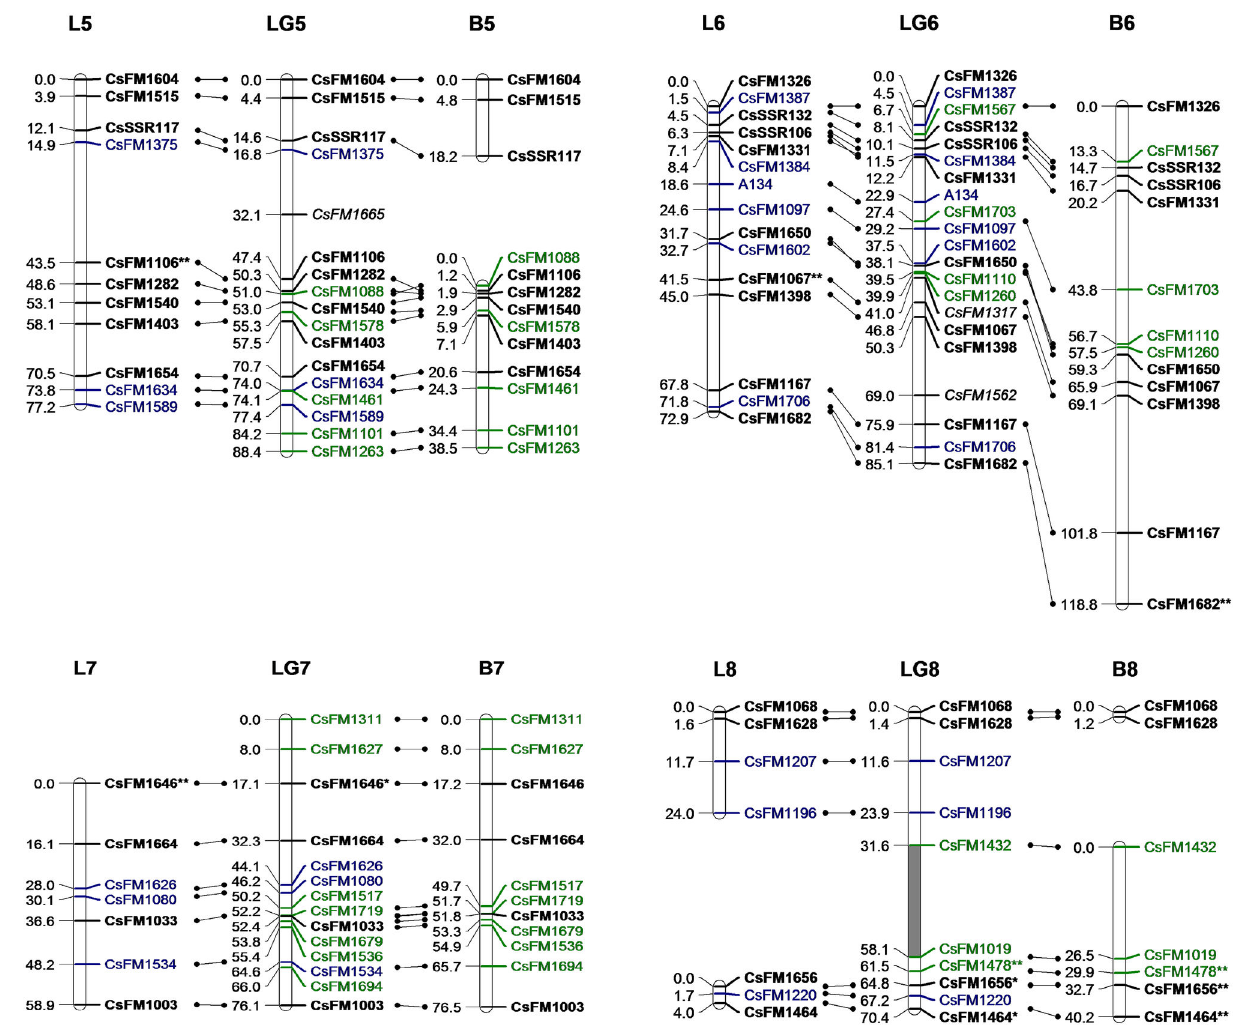
Figure 4. Linkage map based on SSR markers for C . sinensis (LG5-8). See legend of Figure 3. doi: